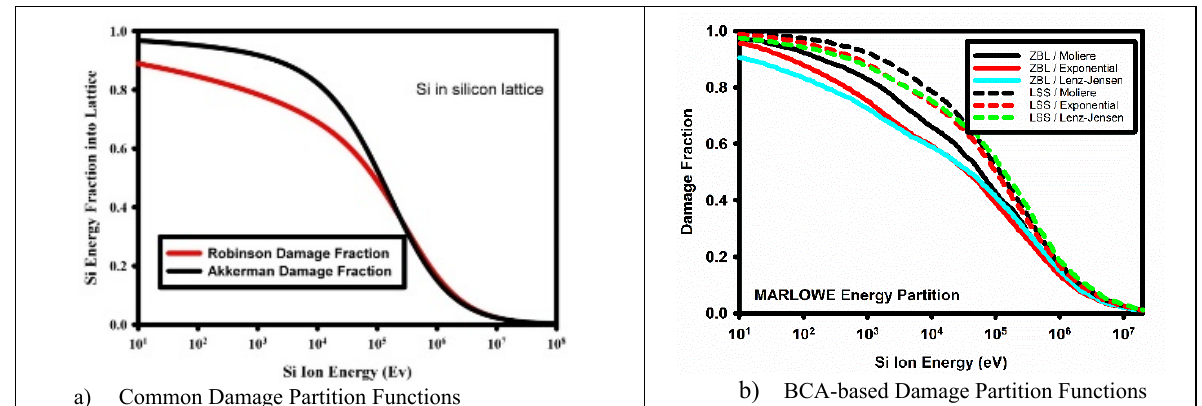
Fig. 10. Variation in the silicon partition function [13]